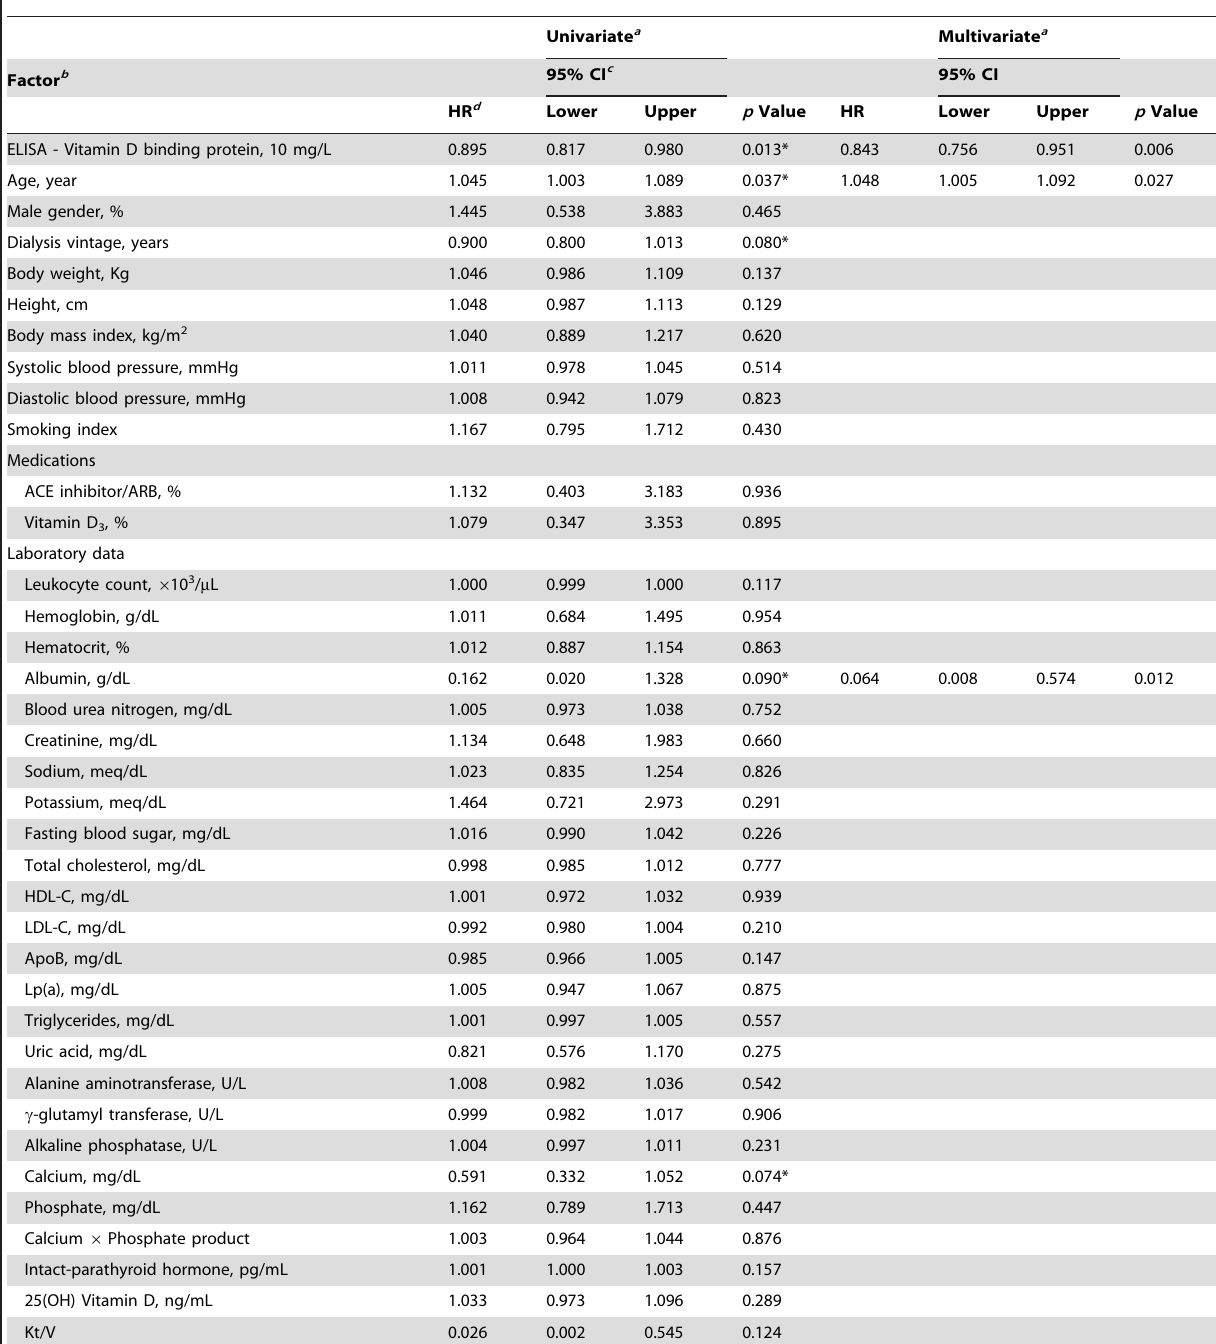
Table 4. Cox proportional hazard model for prognosis of HD patients at a four-year follow-up.